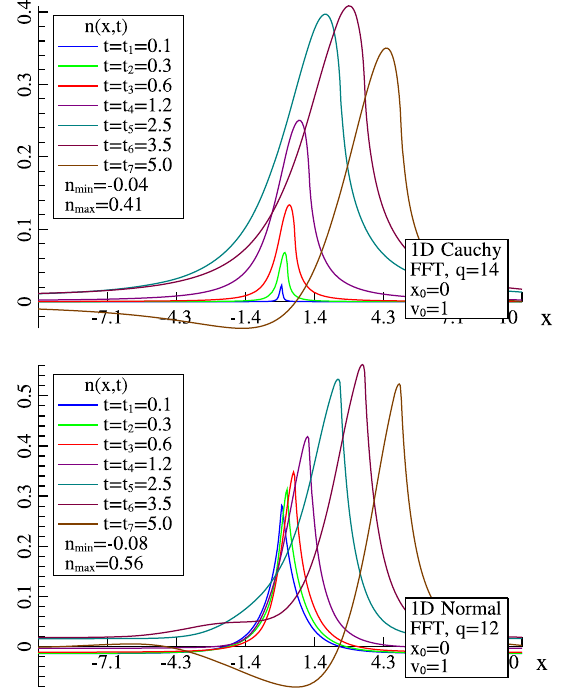
FIG. 4. The density n 1 ð ~ x ; t Þ for the infinite plasma with the 1D Cauchy and normal velocity